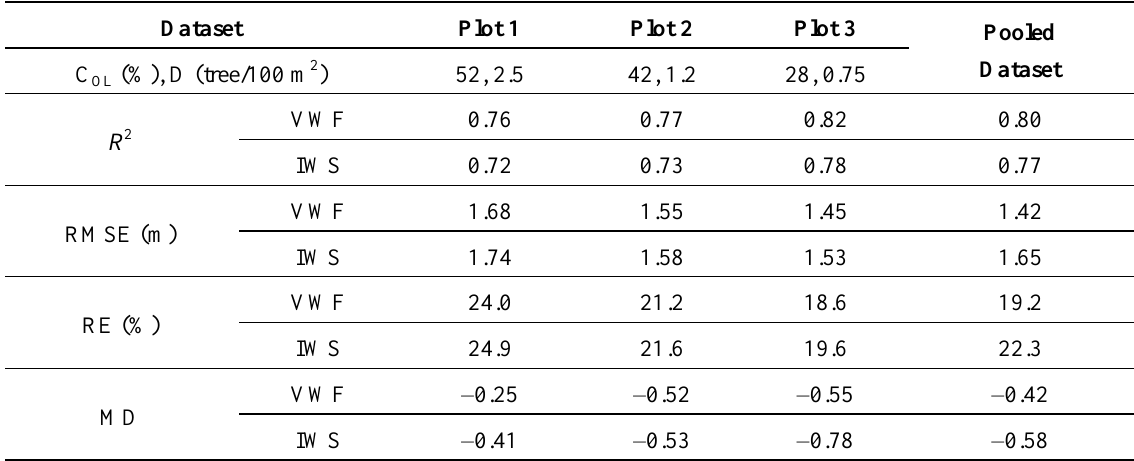
Table 9. Performance of the VWF and IWS methods for estimating tree